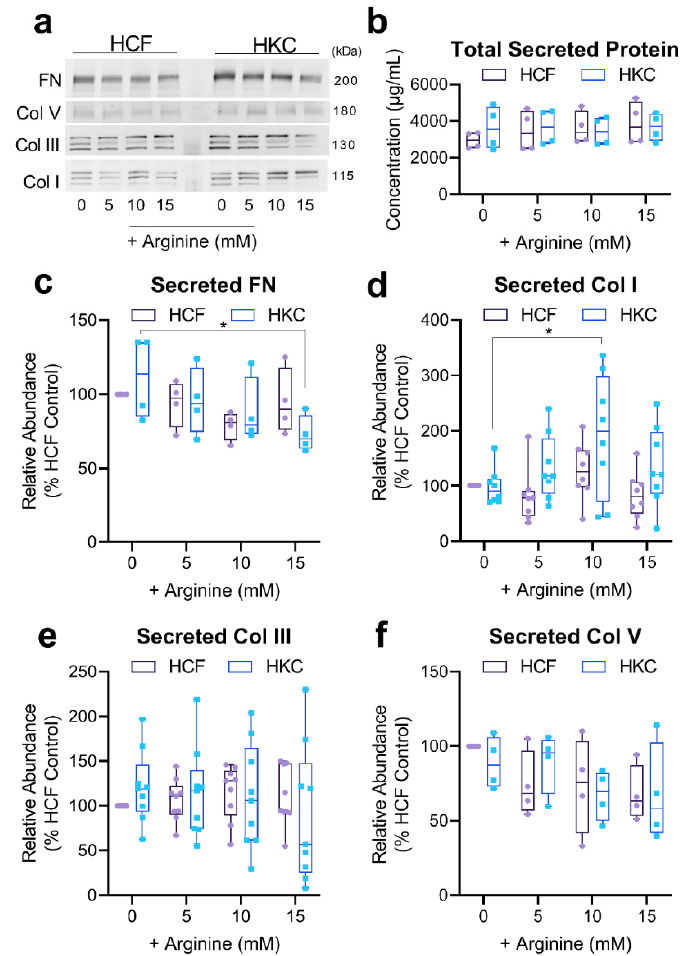
Figure 5. Secretion of matrix components by HCFs and HKCs in 3D constructs with increasing arginine supplementation. ( a ) Western blot of conditioned media isolated from 3D constructs seeded with HCFs and HKCs showing secretion of fibronectin (FN), collagen type I (Col I), collagen type III (Col III), and collagen type V (Col V) following supplementation of increasing concentrations of arginine at week 4. ( b ) Total secreted protein levels determined using a BCA assay. ( c – f ) Quantification of ECM proteins, FN, Col I, Col III, and Col V, found in conditioned media detected by Western blot with values normalized to the HCF control. Data are shown as box and whisker plots (minimum, first quartile, median, third quartile, and maximum) ( n ≥ 4). A two-way ANOVA with Sidak’s multiple comparisons was used to determine statistical significance, with * representing p ≤ 0.05.